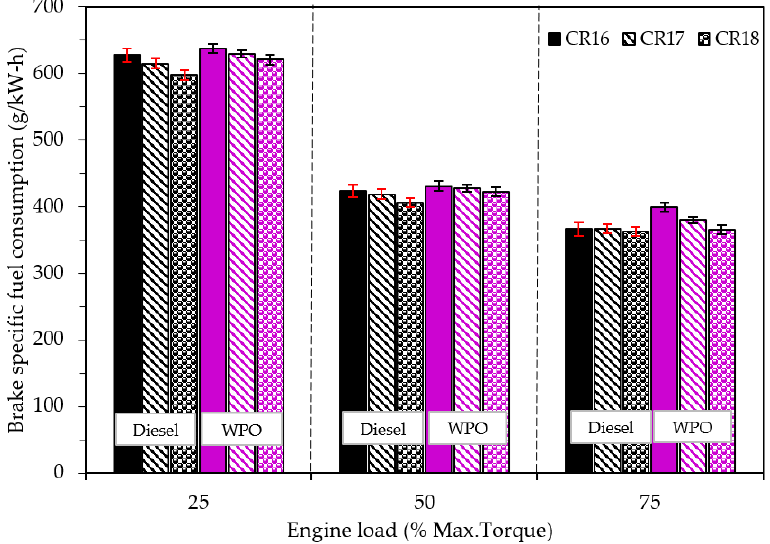
Figure 4. Variation in brake specific fuel consumption (BSFC) with engine loads.